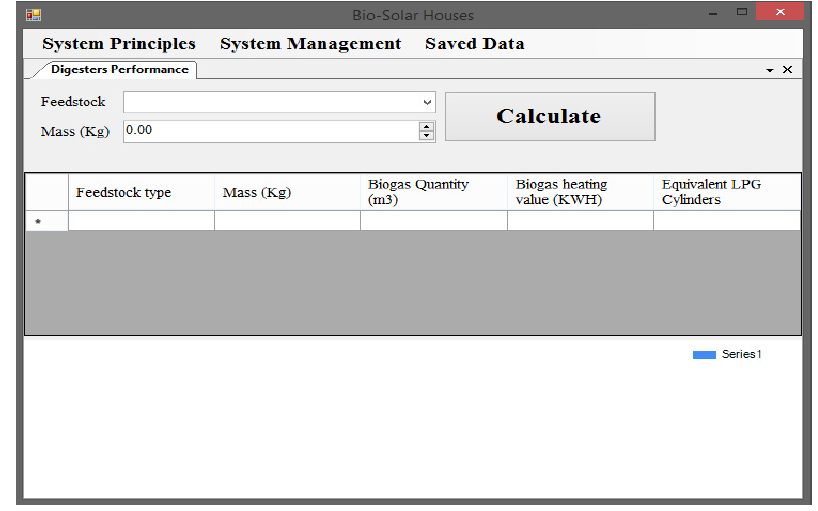
Figure 7. Digesters Performance form in the model.